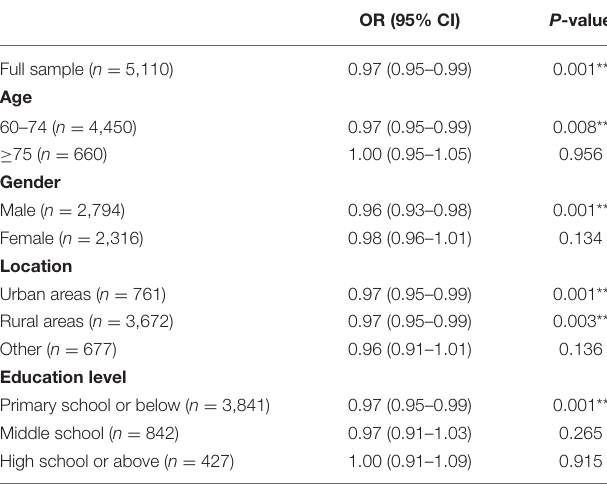
TABLE 6 | Logistic regression analysis of cognitive function and subsequent falls among